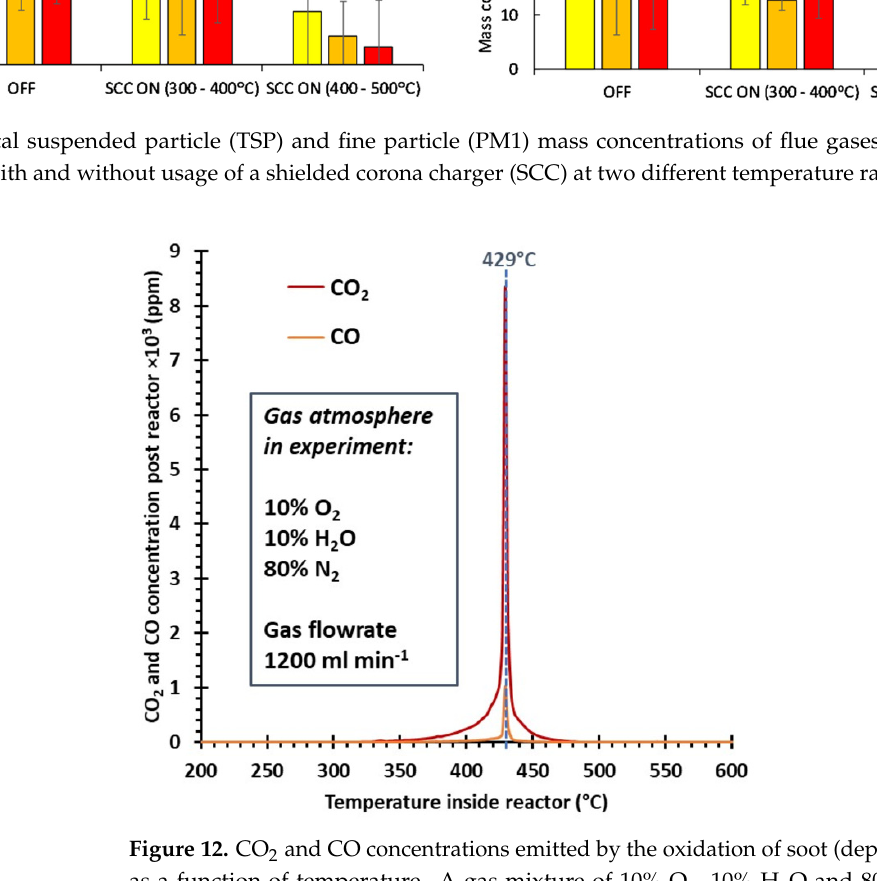
Figure 12. CO2 and CO concentrations emitted by the oxidation of soot (deposited on the SCC- tube) as a function of temperature. A gas mixture of 10% O 2 , 10% H 2 O and 80% N 2 was used in the